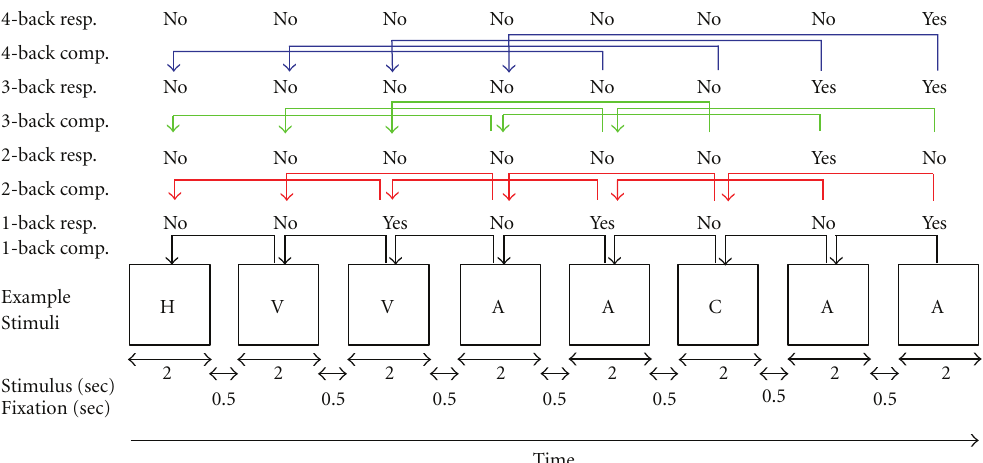
Figure 1: Diagram of sample series of n -back stimuli, timing of stimuli (bottom), expected correct responses, and appropriate stimuli to match to under di ff erent experimental ( n -back)